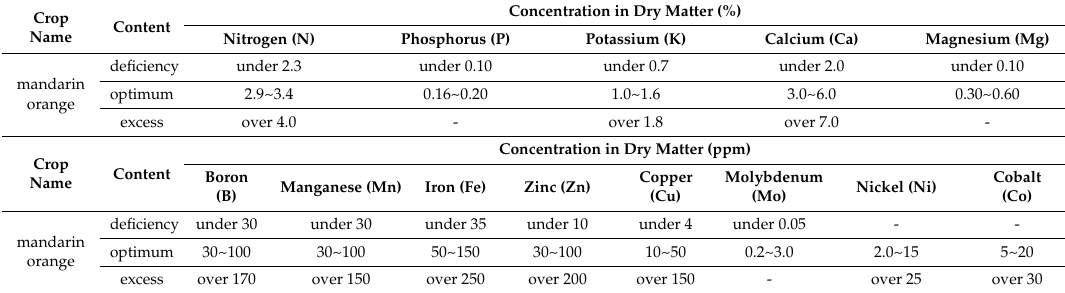
Table 5. Information on the appropriate kinds and contents of elements inside a